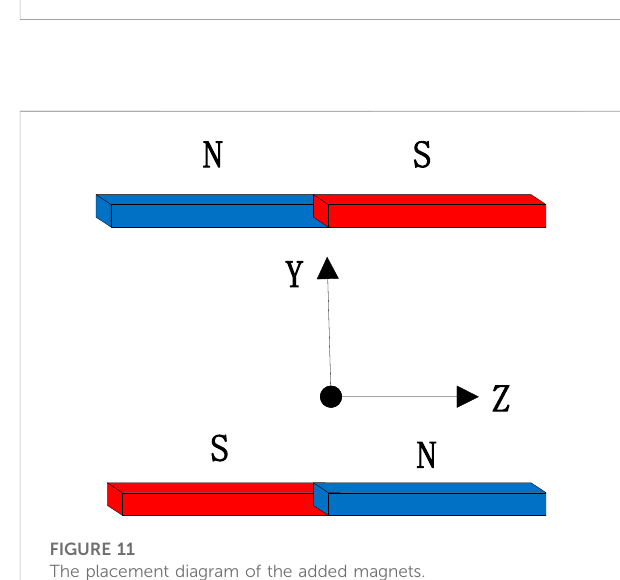
FIGURE 10 The diagram of the bias current I bias and the co-extracted electron current density J e as a function of the PG sheath potential drop U b − V pl .